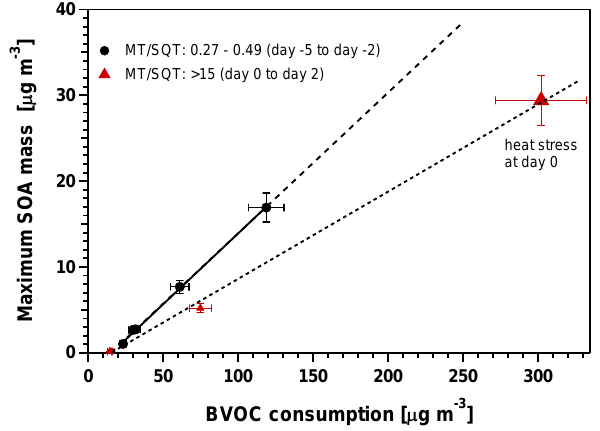
Fig. 5. Maximum BSOA mass produced by OH oxidation of BVOCs emitted from spruce in Experiment #2. Circles repre- sent the data points obtained at MT/SQT ratios of 0.27–0.49 [µgm − 3 /µgm − 3 ] before application of the heat stress (compare Ta- ble 2). The solid line shows the result of linear regression analy- sis giving the yield 17 ± 1% (x-intercept = 16 ± 1µgm − 3 , R 2 = 0 . 999). The large red triangle shows the data point obtained dur- ing heat stress application at day 0 with a MT/SQT ratio of 19 [µgm − 3 /µgm − 3 ]. The dotted line (slope 0.088 ± 0.002, R 2 = 0 . 96) is calculated using the data of day 0 to day 2 with MT/SQT > 15 (compare Table 2). Dashed extrapolation is given for better comparison of the incremental mass yields for both